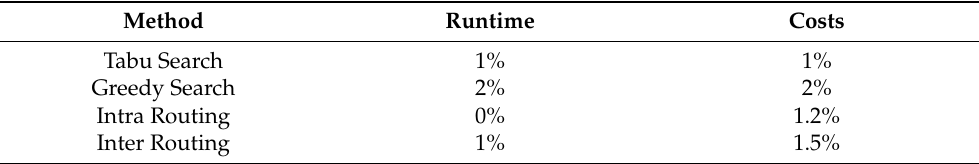
Table 7. Percentage reduction in run time and costs of PSO over other tests results.